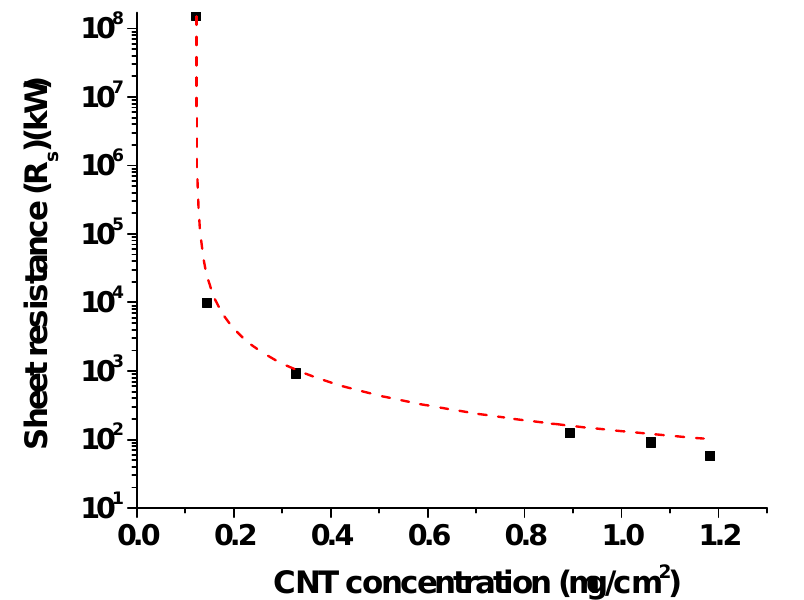
Figure 8. Variation in sheet resistance with CNT concentration. The percolation exponent is 1.42, which confirms transport by individual conducting paths in a two-dimensional